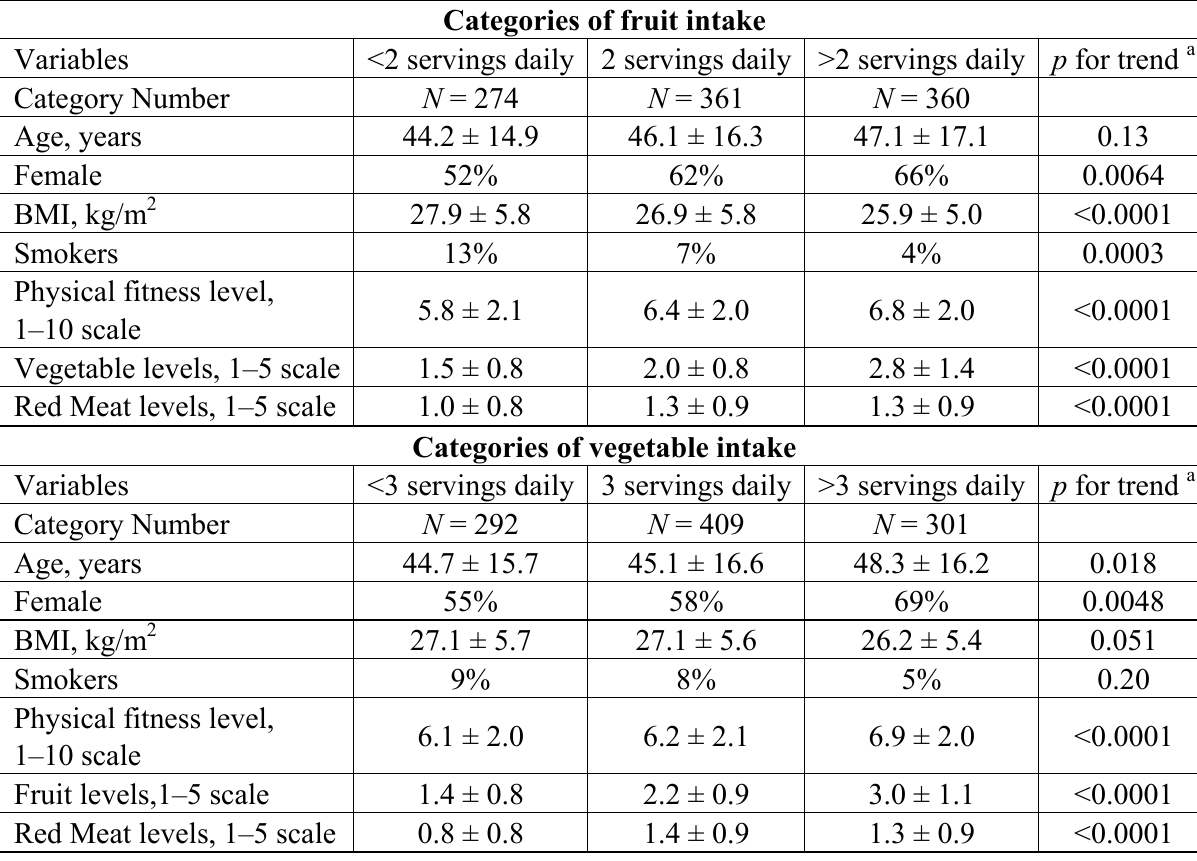
Table 2. Subject characteristics (mean ± standard deviation) by category of fruit and vegetable intake of community cohort.